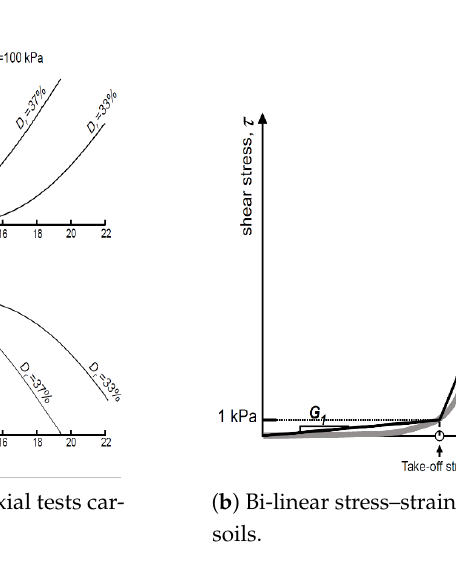
Figure 10. Post-liquefaction behavior of liquefiable soils.